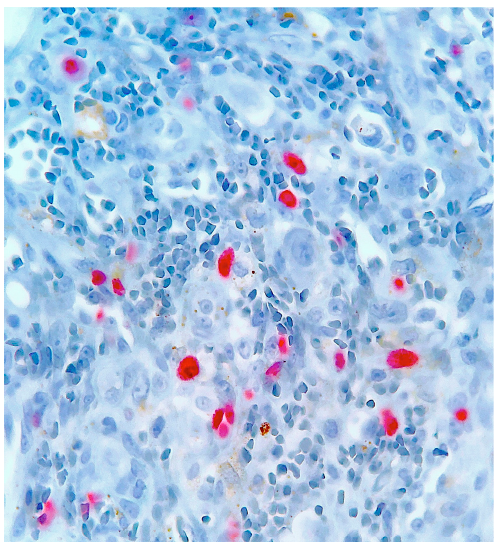
Figure 10. Occasional tumour cells express the MIB-1/Ki67 proliferation antigen (immuno-alkaline